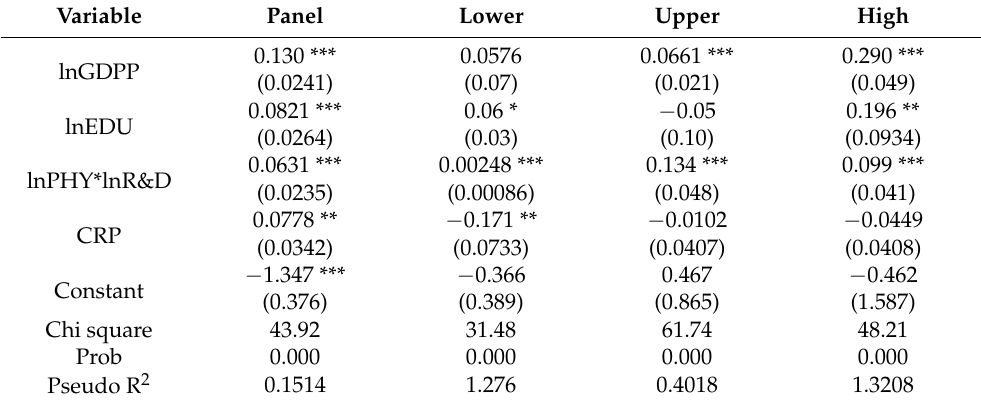
Table 6. Model 2: Tobit